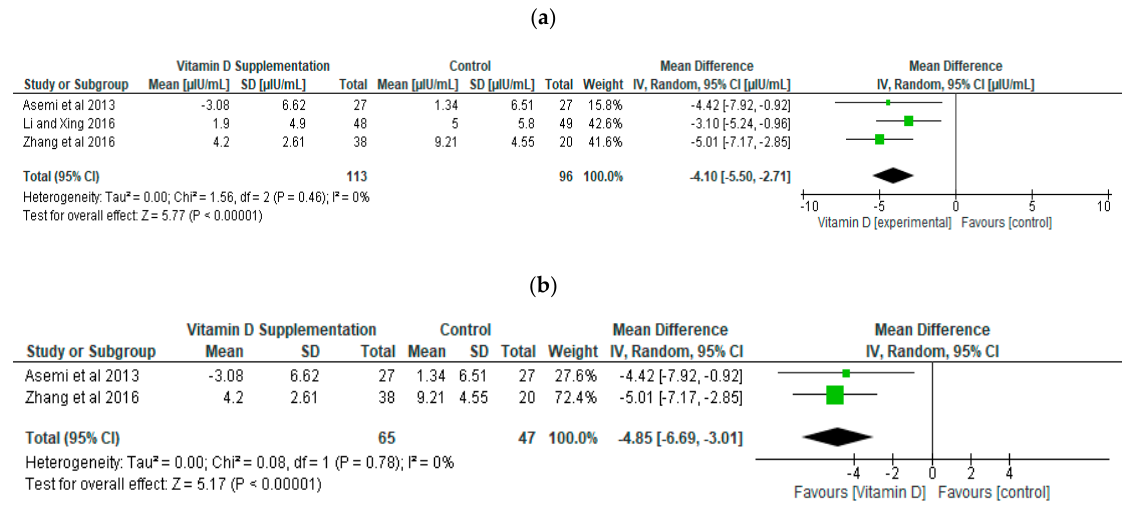
Figure 6. Forest plot of serum insulin concentration µIU/mL. ( a ) Meta-analysis; ( b ) sensitivity analysis.